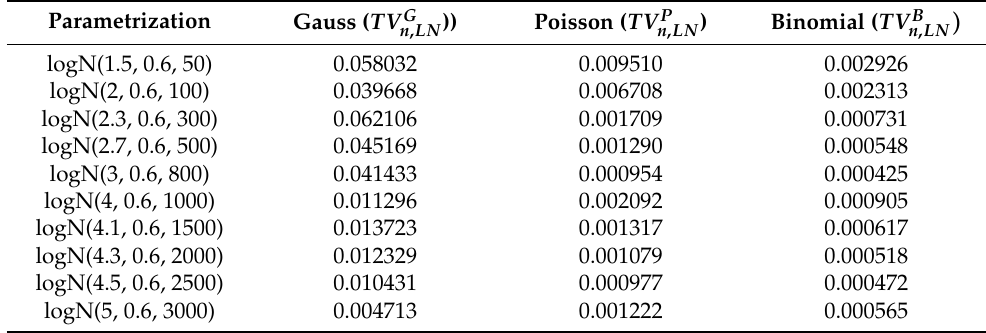
Table 2. Total variational distance between the approximated and the exact degree distributions when the IRG is created using LognormalSeq parametrization.